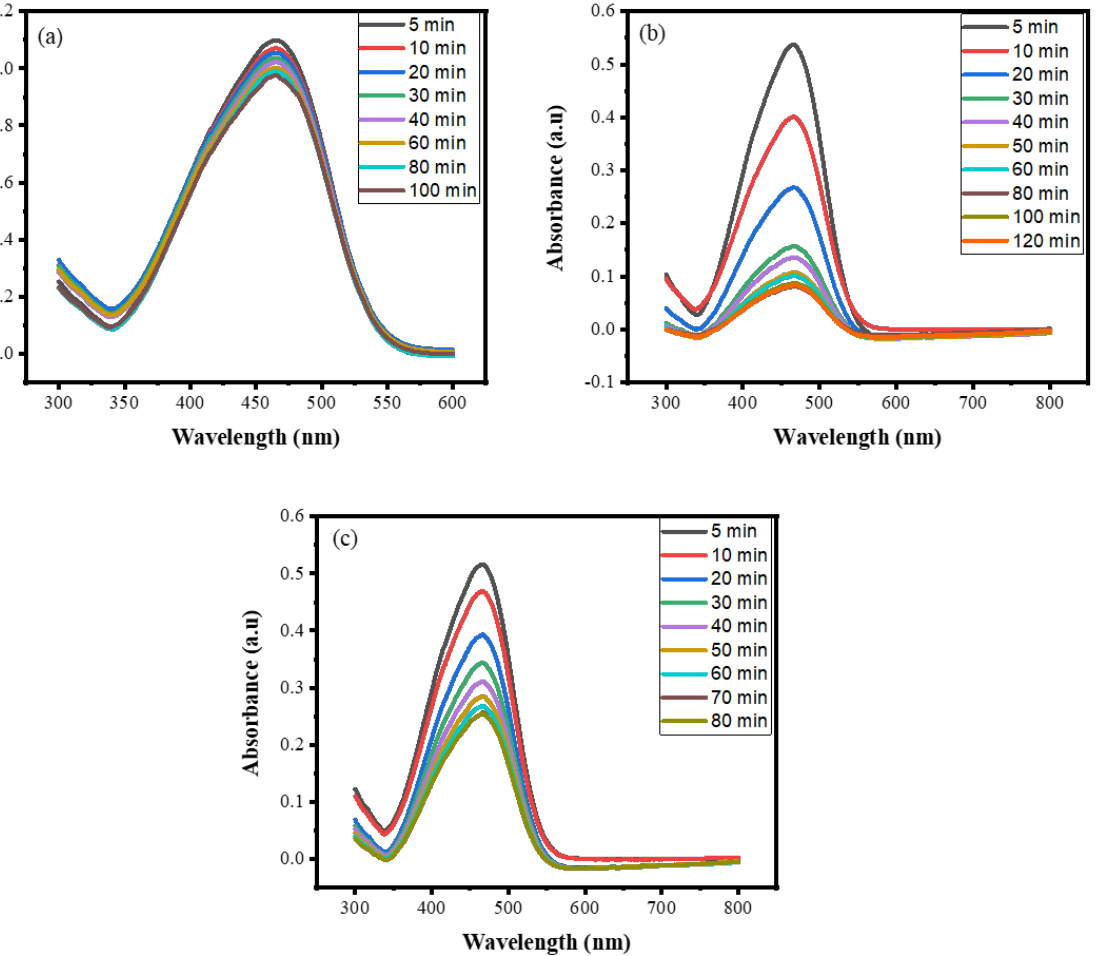
Figure 7. MB dye adsorption in the presence of the Mn 3 O 4 /NiO NC ( a ) at pH of 2, ( b ) at pH of 11, ( c ) at pH of 7 .